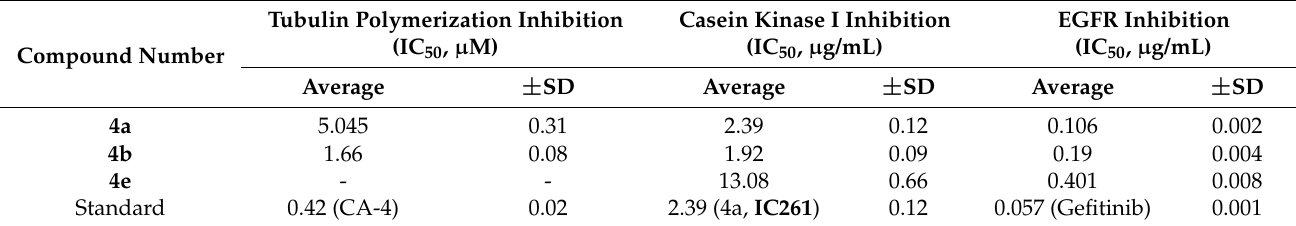
Table 3. Tubulin polymerization inhibitory activity (IC 50 , µ M) for compound 4b compared to CA-4, CK1 inhibitory activity (IC 50 , µ M) of compounds 4b and 4e compared to compound 4a (IC261), and the EGFR inhibitory activity (IC 50 , µ g/mL) of compounds 4b and 4e compared to